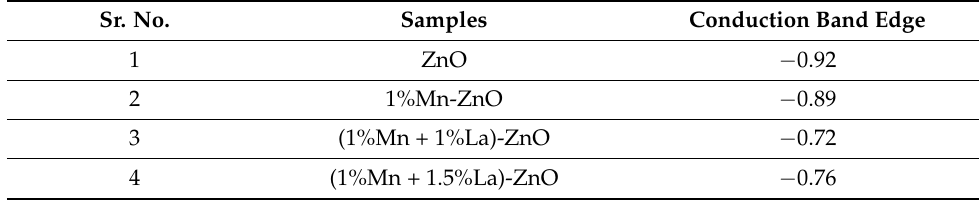
Table 2. Conduction band edges of pure and co-doped ZnO films. Sr. No.